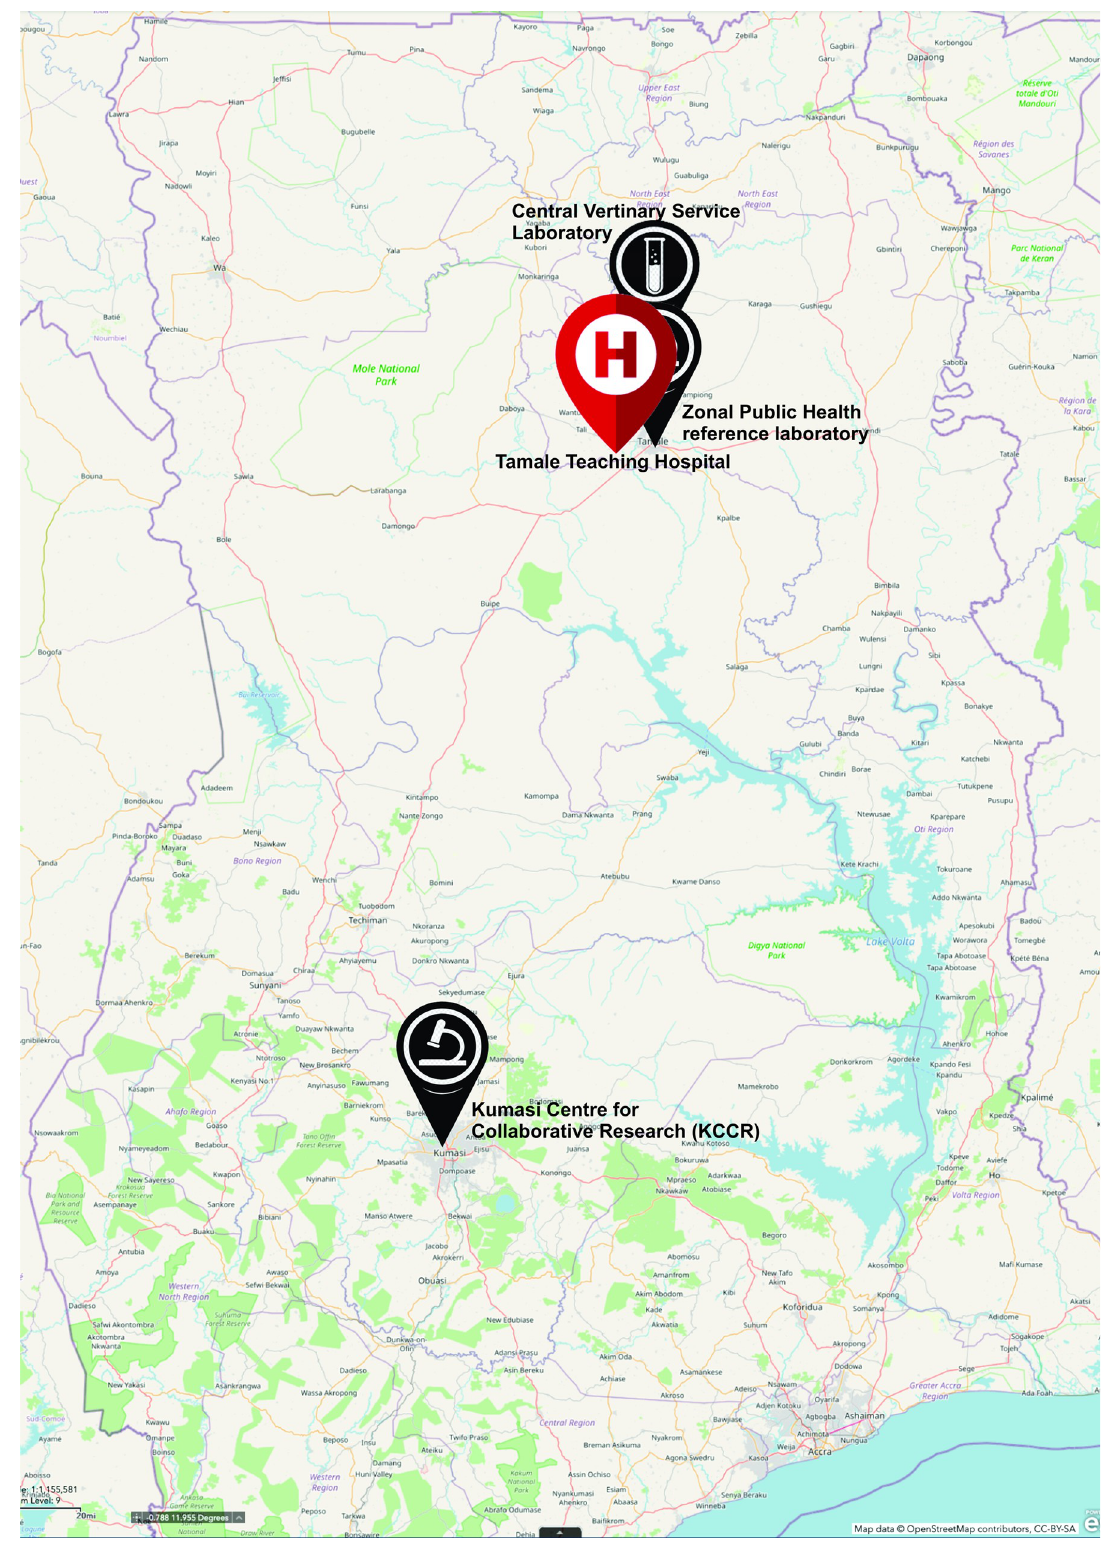
Fig 1. Map of Ghana showing the Tamale teaching hospital and the SARS-CoV-2 PCR testing facilities used in this study.